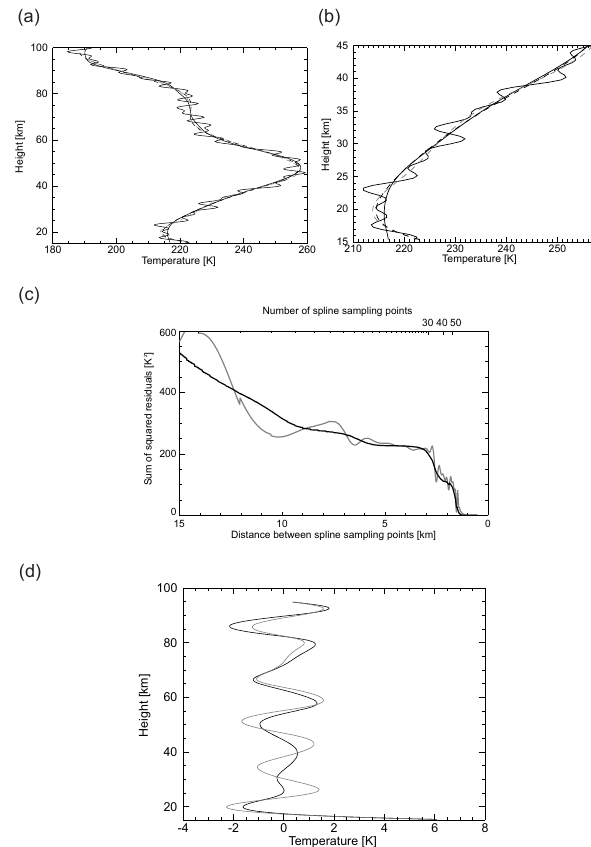
Figure 7. (a) The solid oscillating (non-oscillating) line depicts three sinusoidals with vertical wavelengths of 3, 5 and 13km, phase 0, π/ 3 and π/ 5, and amplitude 2.0 (the CIRA background). The dashed line shows the spline approximations for the repeating (black) and non-repeating (grey) spline approach (sampling point distance 10km). Part (b) is as part (a) but focussing on the height interval between 20 and 40km for which the sum of squared resid- uals is calculated in part (c) . The range of the x and y axes differs from the ones used in Figs. 3 and 6a. Part (d) shows the differ- ence between the spline (i.e. the approximated background, grey: non-repeating approach, black: repeating approach) and the CIRA- background (i.e. the original background).